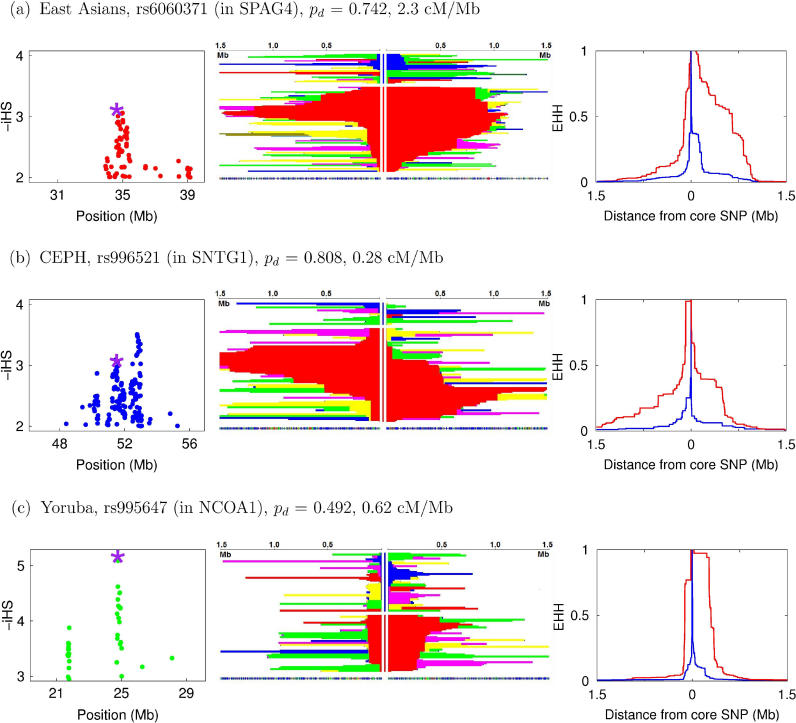
Signals of Selection for Three Candidate Selection Regions Discussed in the TextThe columns show (left) scatter plots of negative iHS scores, (center) haplotype plots, and (right) decay of haplotype homozygosity. In each case the core SNP for the center and right-hand plots was chosen as a SNP with high negative iHS score (starred in the scatter plots); the allele marked in red is derived. For each signal, values are listed for the derived allele frequency (pd) and the local deCode recombination rate estimate.